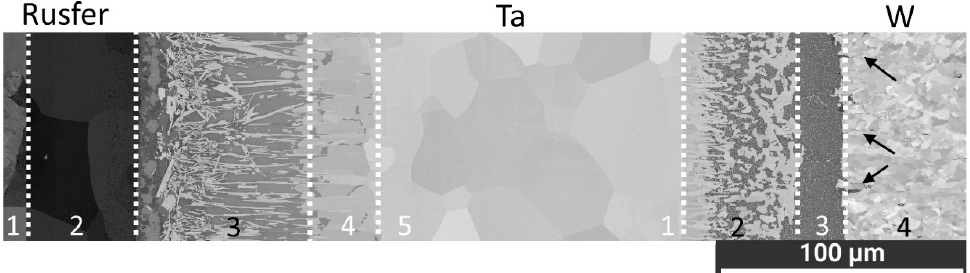
Figure 6. Full view of Rusfer/Ta/W joint brazed by TiZr4Be alloy under 1100 °C, 1 h + 720 °C 3 h brazing mode.